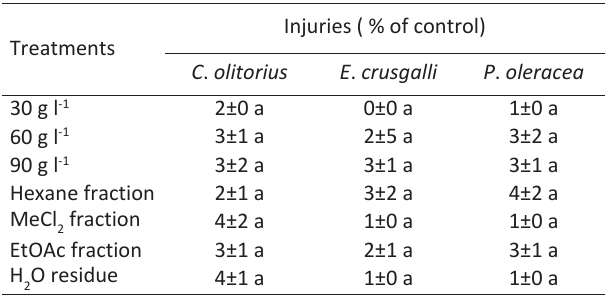
Table 5 - Effect of aqueous celery extract and its fractions on the growth of two-weeks-old of three